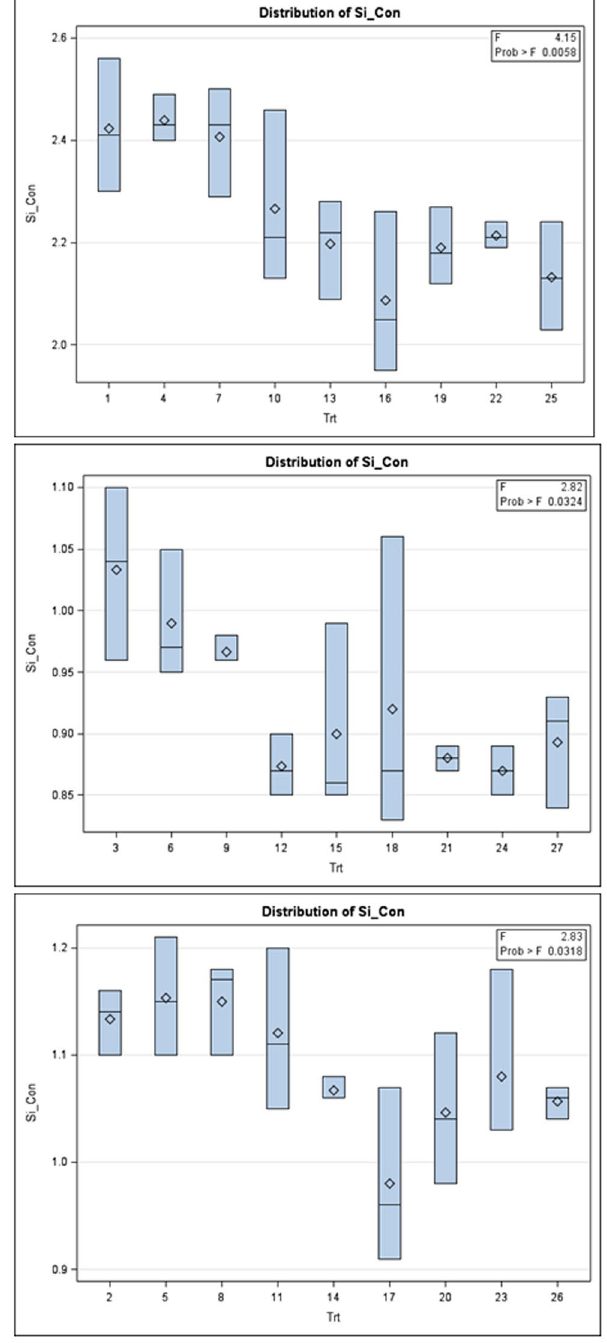
Figure 6. Univariate Box plot results following multivariate MANOVA for the silicon (Si) content plant characteristic over the 3 levels of the N factor. Compare the subtle differences in eye fit lines (in sets of 3 groups, moving left to right) within each sub-panel and among the